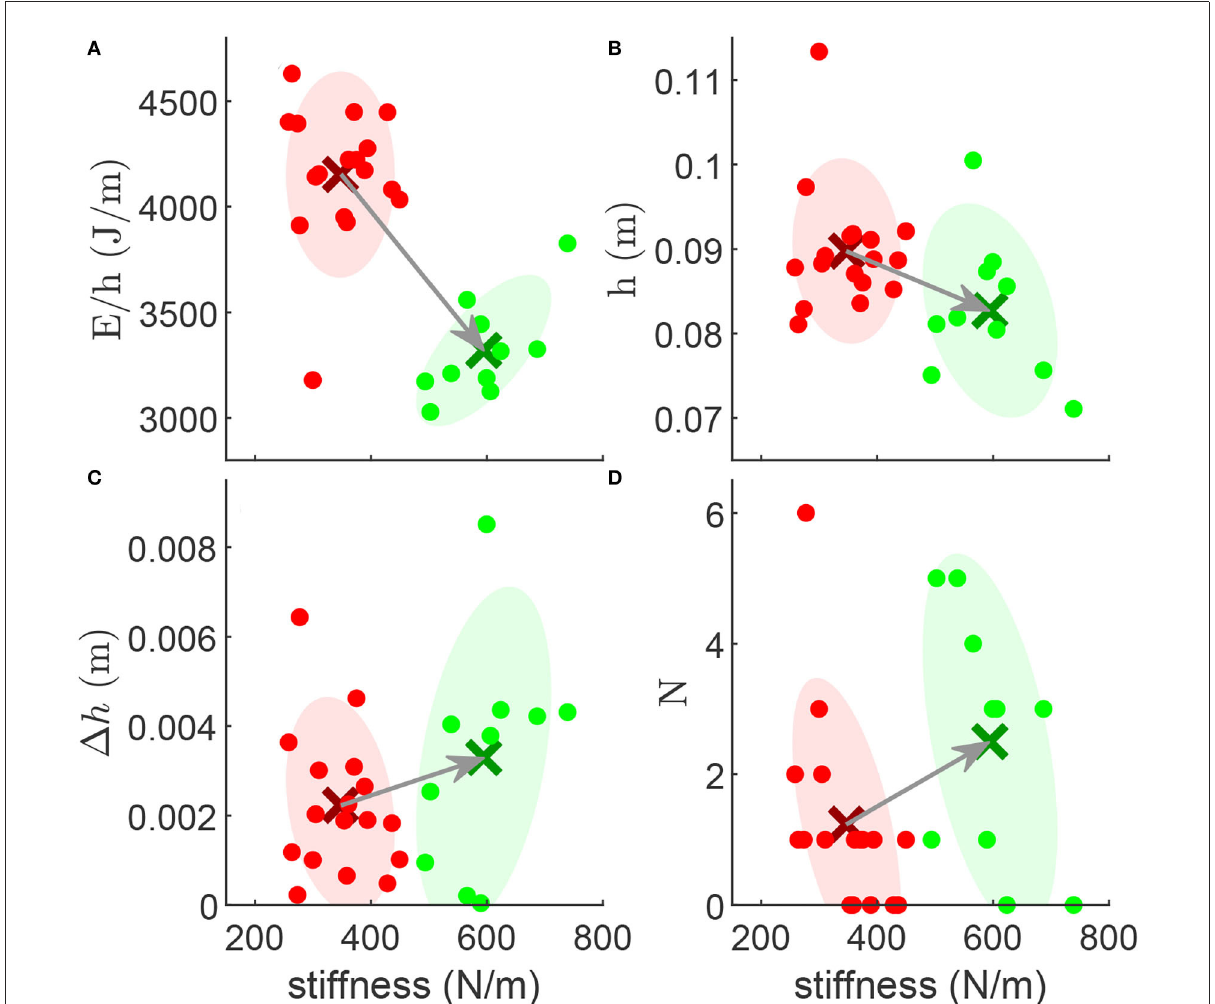
FIGURE6 The relation between the leg unloading stiffness and the (A) normalized energy consumption ( E / h ), (B) hopping height ( h ), (C) stable hopping height difference ( 1 h ), (D) number of hops ( N ) required to recover from the perturbation. The red and green dots denote the low stiffness and high stiffness conditions, respectively. The red and green ellipses denote the covariance of the low and high stiffness data groups (with 1 SD), respectively. The cross markers denote the mean of the data